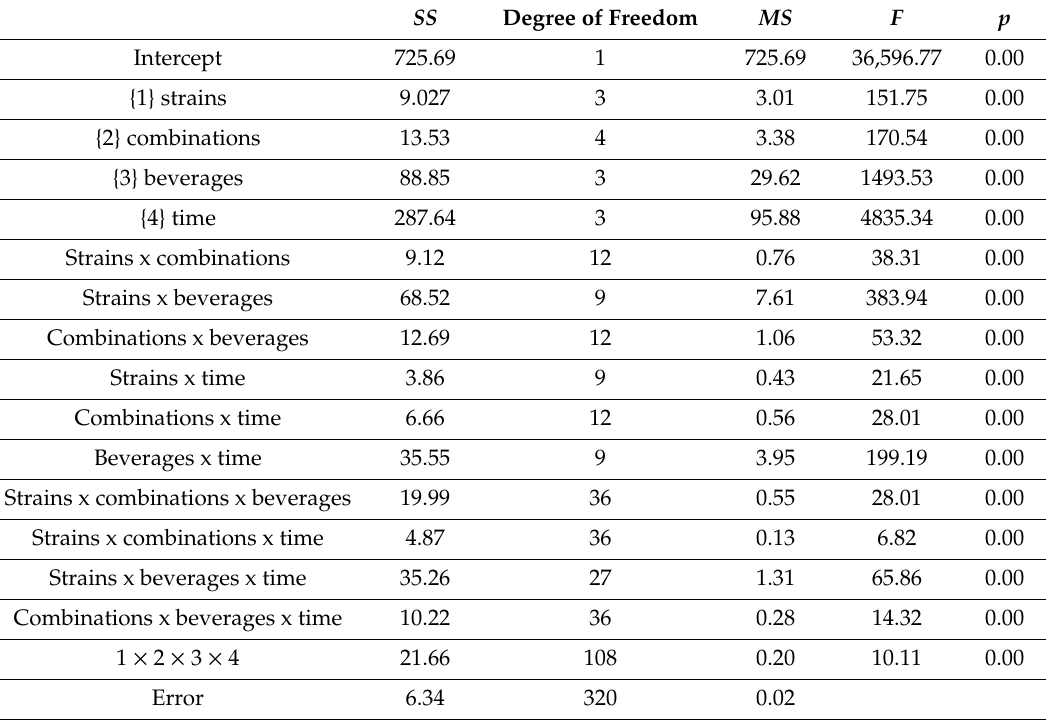
Table 3. Standardized e ff ects of beverages, combinations and time on acidification. The results were obtained by multifactorial analysis of variance (MANOVA) and Tukey’s test ( p < 0.05) as the post hoc comparison